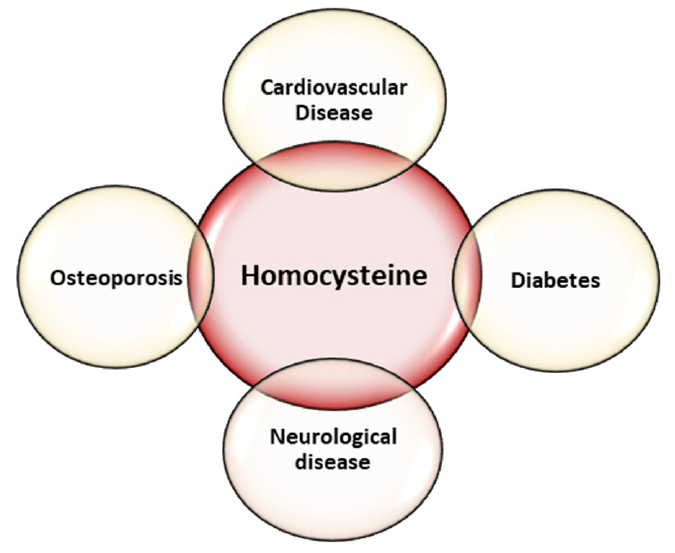
Figure 1. Diseases associated with homocysteine.